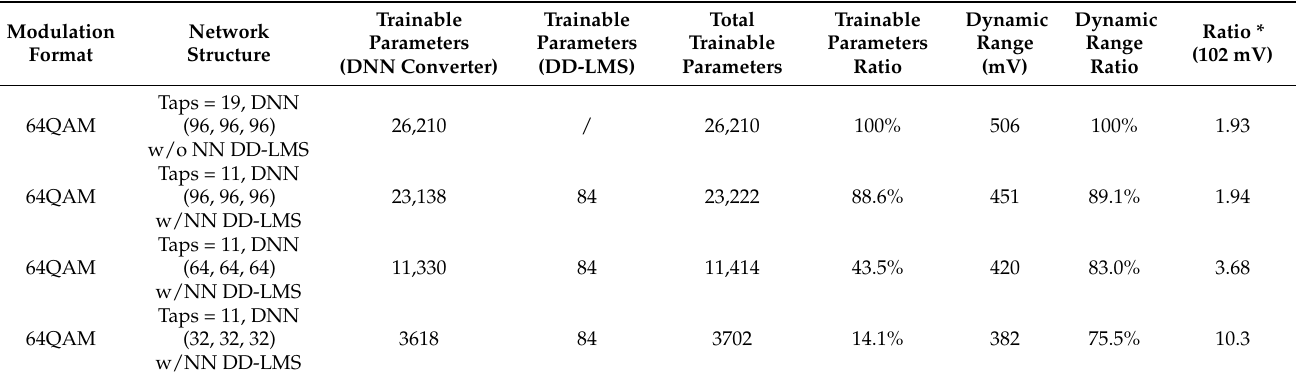
Table 2. Comparison of different receivers in 64QAM UVLC